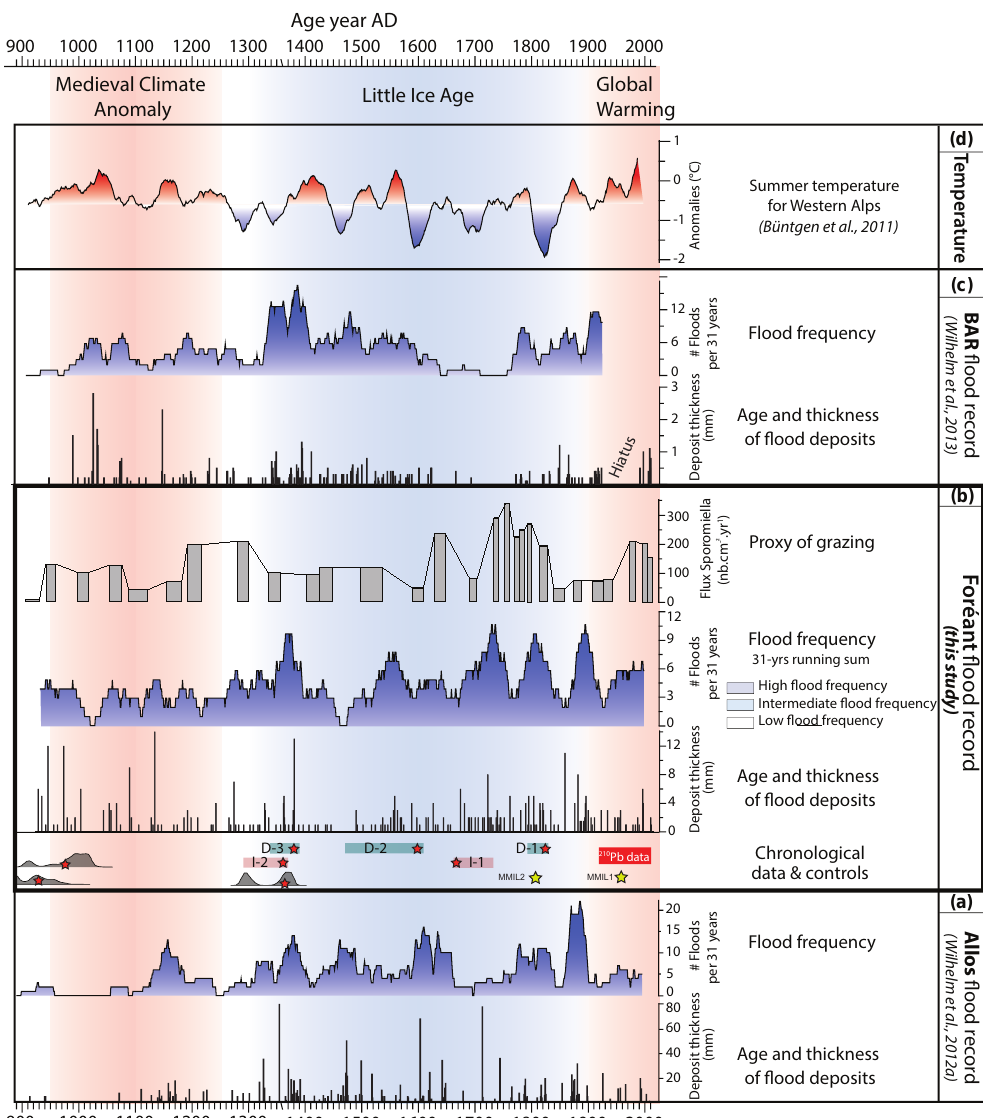
Figure 8. Comparison over the last millennium of (b) the reconstructed Foréant flood frequency (31-year running average) and intensity (thickness of flood deposits) with (a) the Allos flood record from the southern French Alps (Wilhelm et al., 2012a), (c) the BAR flood record from the northern French Alps (Wilhelm et al., 2013) and (d) the tree-ring-based summer temperature for the European Alps (Büntgen et al., 2011). The reconstructed Sporomiella -type flux is also shown next to the Foréant flood record to highlight potential human impacts (i.e. grazing) on the erosion processes that might bias the flood record. The red stars below the Foréant record show the chronological markers with their 2-sigma uncertainty